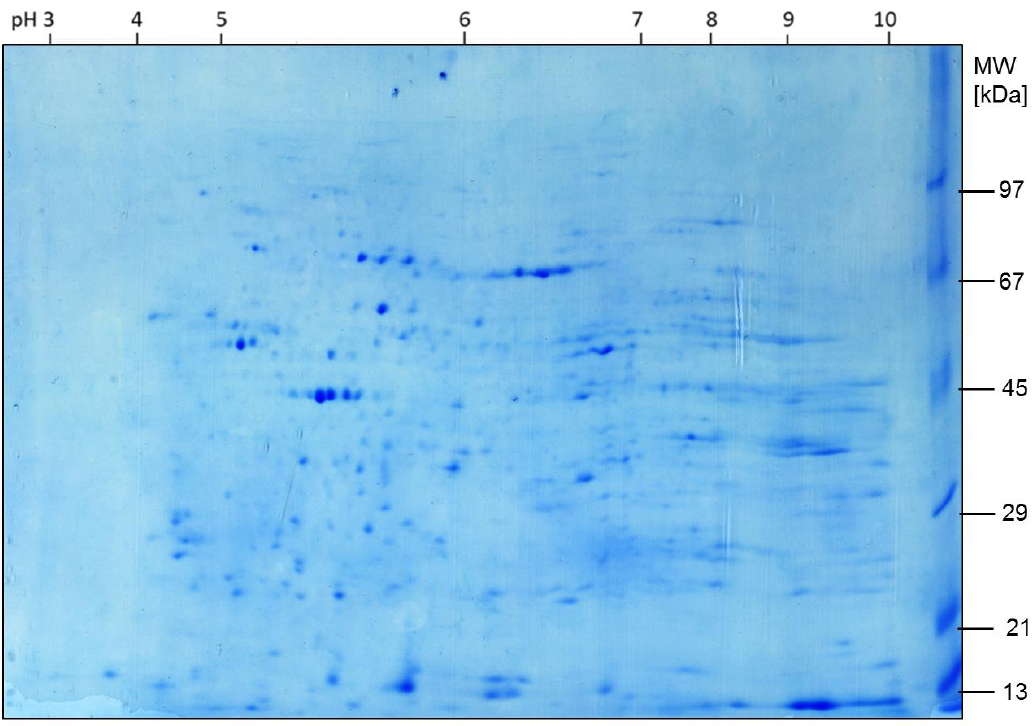
Figure 6. Sample gel of the control group at 3 days after hyperoxia (staining: Coomassie blue).